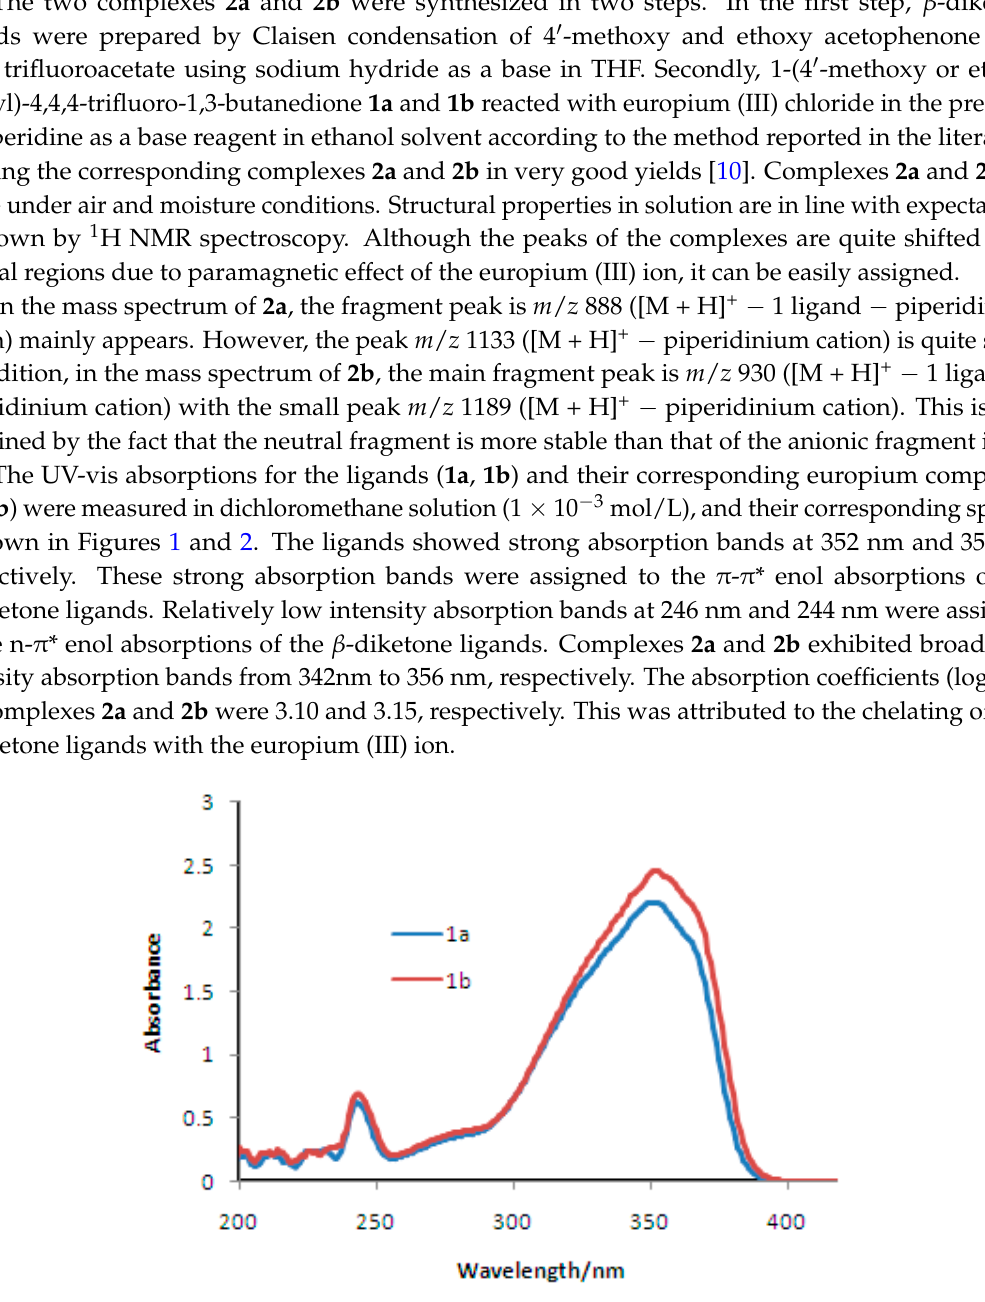
Figure 1. UV-Visible spectra of the ligands 1a and 1b .